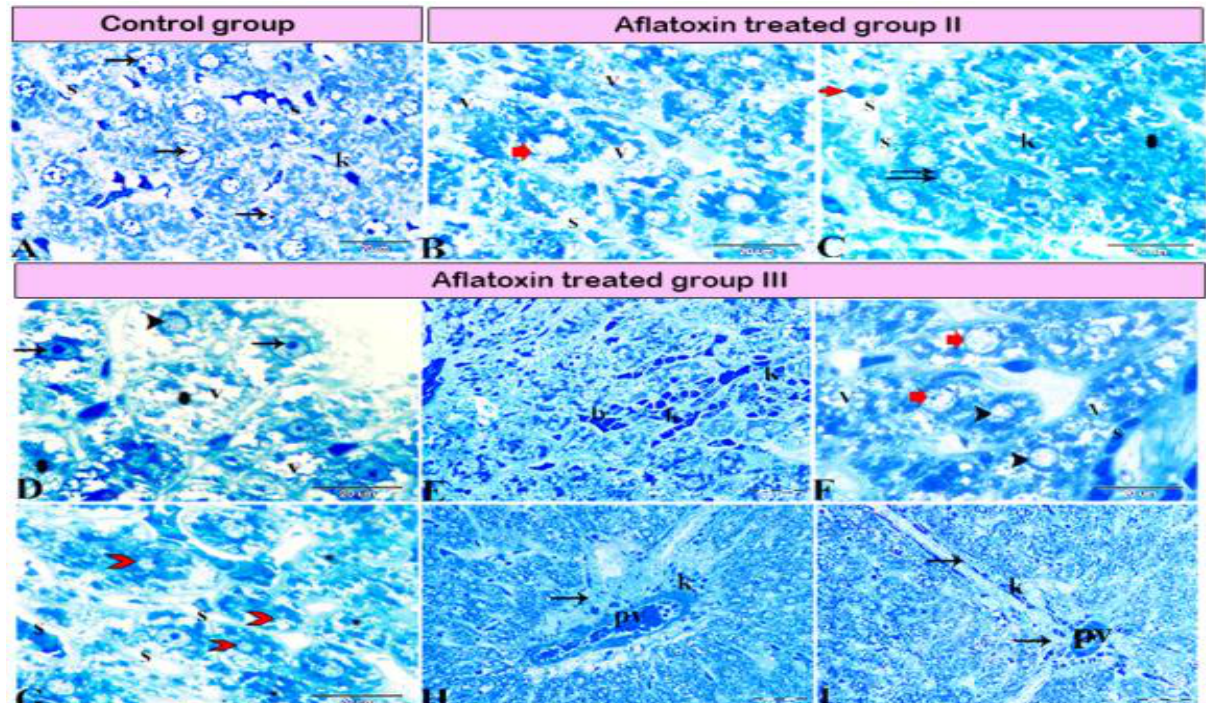
Figure 4. Photomicrograph of a semi-thin section stained with Toluidine blue. ( A ) Normal hepatocytes (arrows) with narrow blood sinusoids (S) in between; note the presence of Kupffer cells (K) in the sinusoids. ( B, C ) Aflatoxin B1-treated rat from group II. ( B ) hepatocellular vacuolar degeneration (V), dilated sinusoids (S), and presence of hepatic megalocytes (red arrow). ( C ) Binucleated hepatocytes (double arrow), incomplete mitotic division (red arrow), area of necrosis (star), dilated sinusoids (S), and marked Kupffer cell (K) proliferation inside the lumen. ( D – I ) AFB1-treated rat from group III. ( D ) Severe hepatocellular vacuolar degeneration (V), some hepatocytes with basophilic bodies (arrows), vesicular nuclei (arrowhead), and other hepatocytes showing necrosis with karyolitic nuclei (stars). ( E ) Sinusoids dilated and filled with blood (b) and marked Kupffer cell (K) proliferation inside the sinusoidal lumen. ( F ) Hepatocellular vacuolar degeneration (V), presence of hepatic megalocytes (red arrows), and necrotic hepatocytes (arrowheads). ( G ) Hepatocellular necrosis (red arrowhead) with notable areas of cellular necrosis and lost detail (star). ( H ) Severe periportal fibrosis (arrow), with the portal vein (PV) engorged with blood, severe fibrosis, and marked Kupffer cell proliferation (K). ( I ) Marked fibrosis around the portal vein (PV), which diffused inside the hepatic lobule forming tracts of fibrosis (arrows).